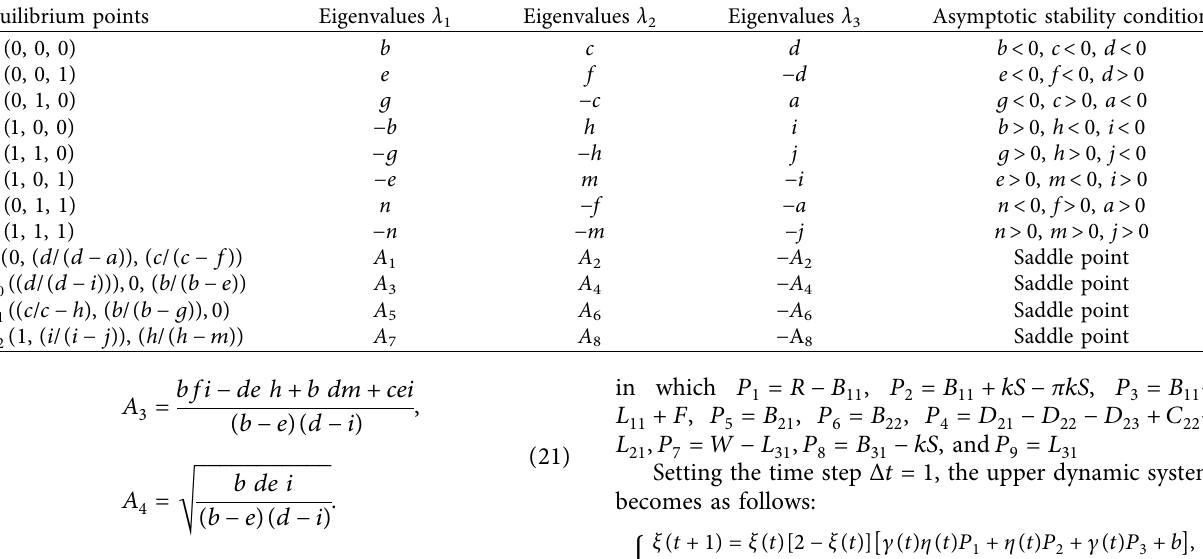
Table 3: Eigenvalues and asymptotic stability conditions of the Jacobian